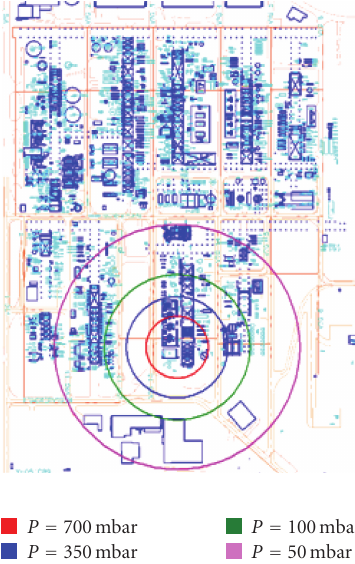
Figure 10: Structural damage using Slam threshold values for scenario 1: D1538.